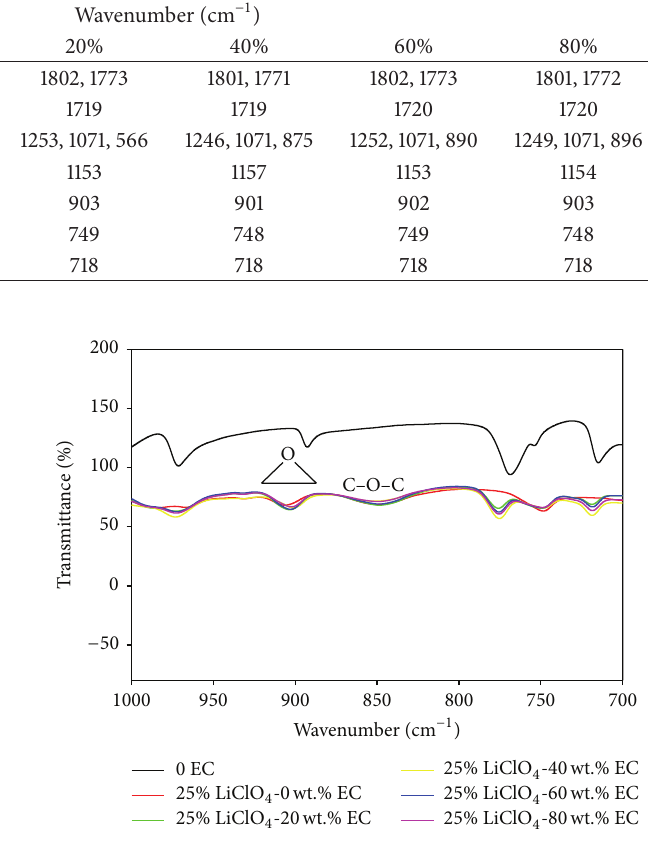
Figure 7: FTIR spectra of PGMA-25 wt.% LiClO 4 -EC based polymer electrolyte as a function of EC in the wavenumber region 1000–700 cm −1